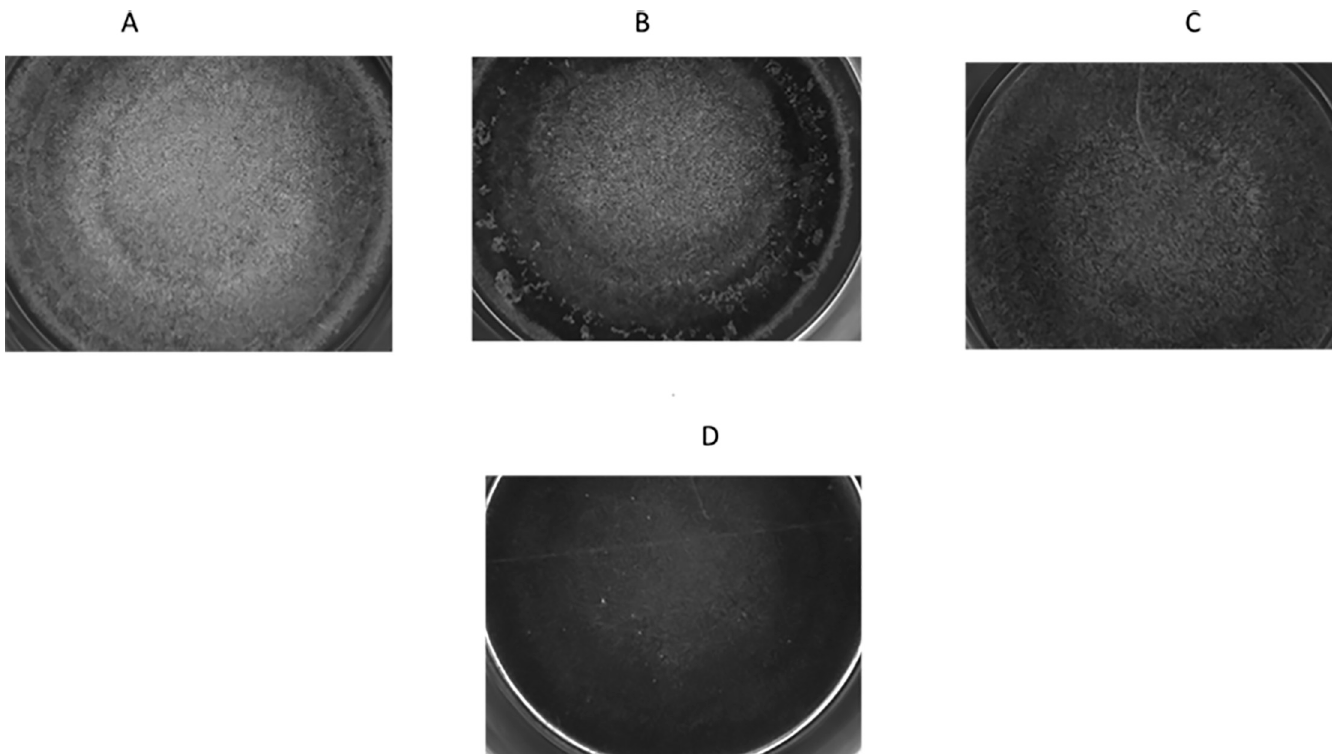
Fig 2. Structure of biofilms. Light microscopy images of formed biofilms. (A) Untreated. (B) Treated with single AraS. (C) Treated with single MET. (D) Treated with the combination of AraS and MET.